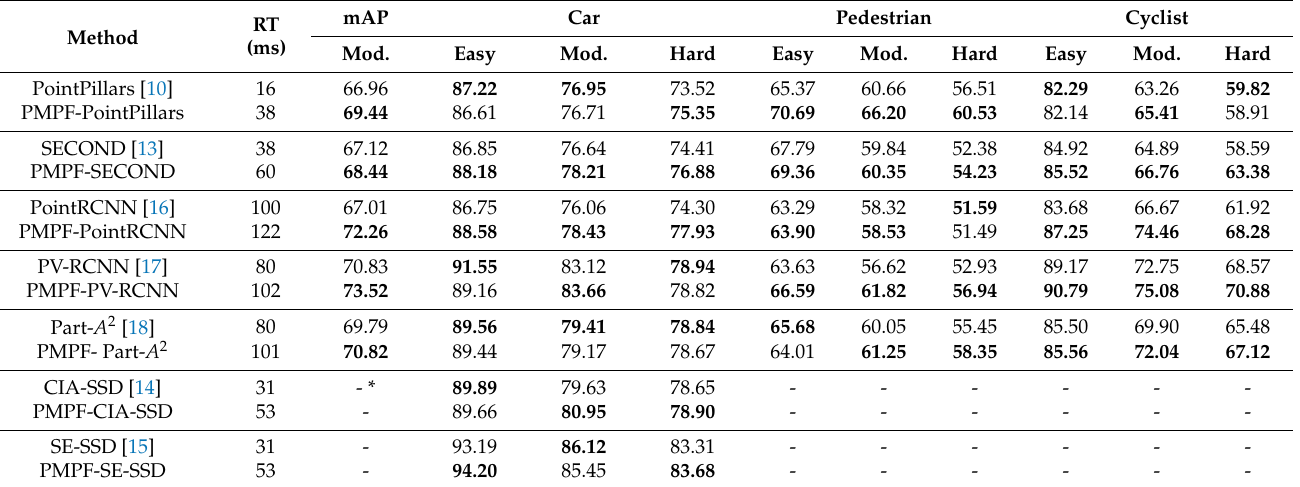
Table 1. Applied to SOTA LiDAR-based object detectors for PMPF. All LiDAR methods show improved 3D mean accuracy precision (mAP) for car, pedestrian and cyclist on the KITTI validation set. Abbreviations: runtime (RT).